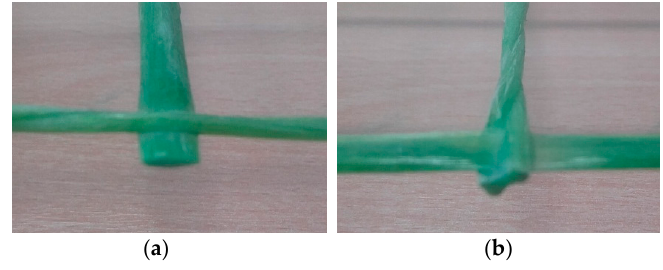
Figure 5. 66 × 66 mm 2 GFRP grid: ( a ) weft direction (SR type); ( b ) warp direction (SC type).